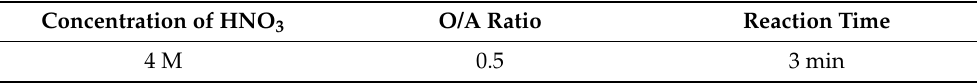
Table 6. Optimal conditions of the stripping experiment with HNO 3 .